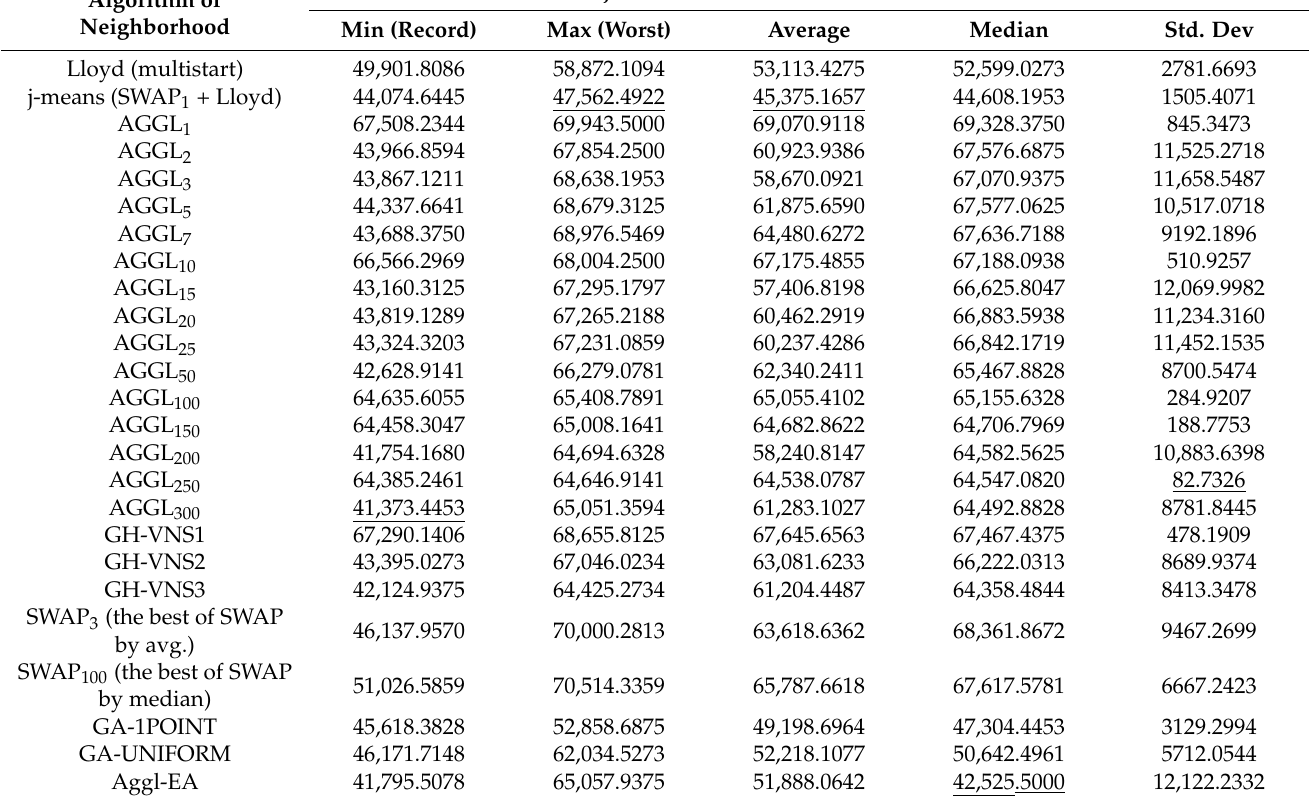
Table A12. Comparative results for Individual Household Electric Power Consumption (IHEPC) dataset. 2,075,259 data vectors in R 7 , p = 300 centers, time limitation 5